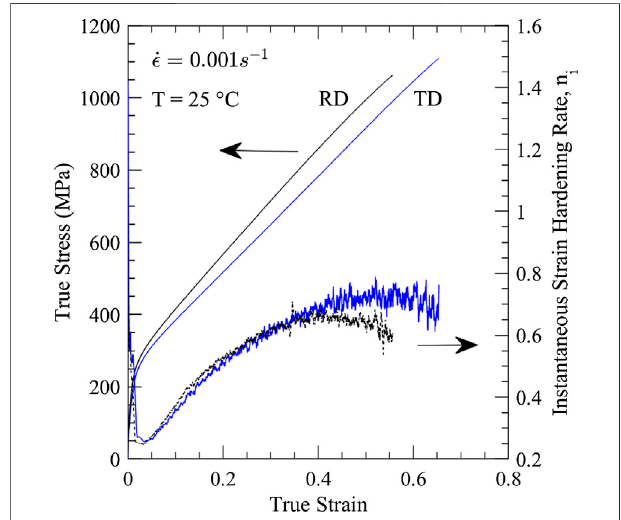
FIGURE 1 | Baseline mechanical properties of a 304 stainless-steel in the rolling (RD) and transverse (TD) directions of the sheet with instantaneous strain hardening exponent (n i ) plotted to the onset ofnecking. The mechanical propertiesofthesteelvarywithorientationrelativetotherollingdirection, and there is signi fi cant strain hardening in the samples due to the TRIP